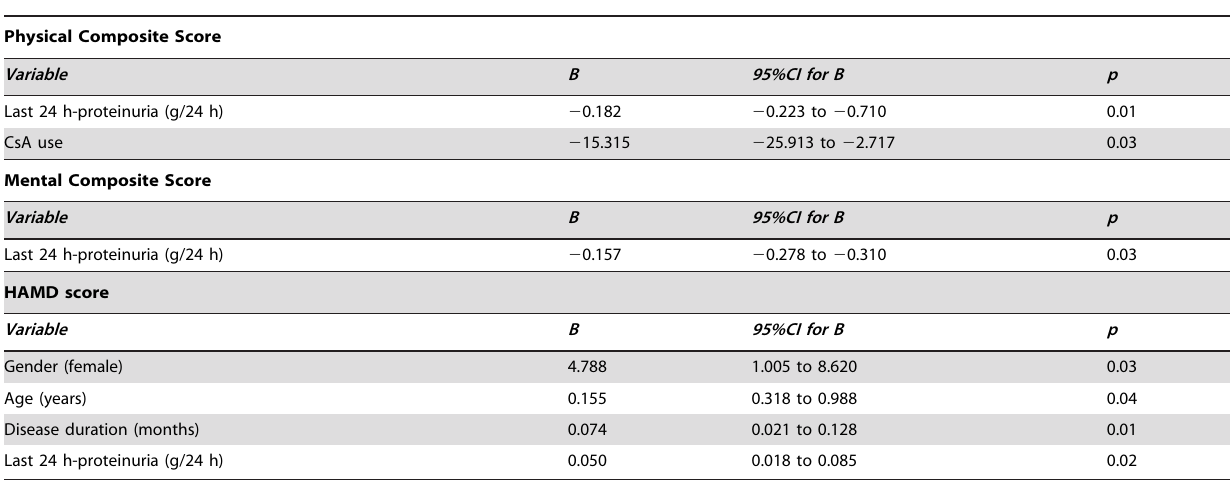
Table 5. Variables independently associated with PCS, MCS and HAMD